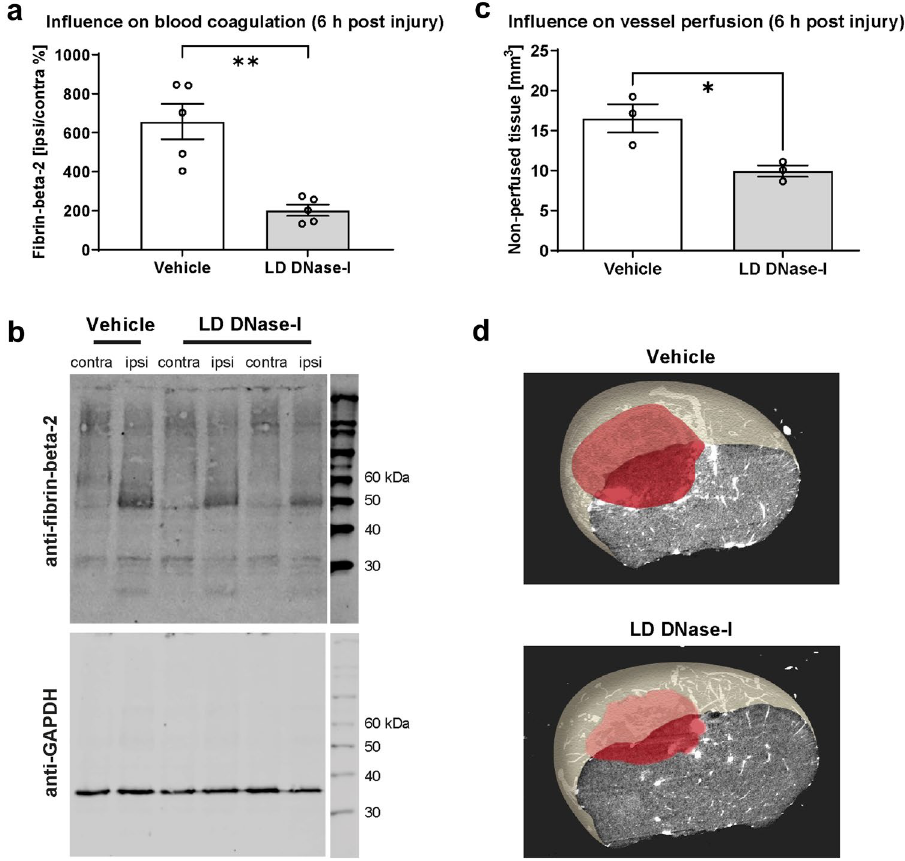
Figure 4. Regulation of coagulation and vessel perfusion post-CCI. ( a , b ) Western blotting of Fibrin-Beta-2 6 h post-CCI, blots were revealed by near infrared laser scanning, quantification was performed with ImageJ, indicating decreased expression following LD DNase-I treatment compared to vehicle (n = 5 mice/group). ( c , d ) Characterization of thrombus formation using cast material injection and micro-CT imaging (n = 3 mice/ group). The area of non-perfused brain tissue (red shading) did not differ significantly between treatment groups. A significance level p < 0.05 is marked with *, p < 0.01 with **, and p < 0.001 with ***. All data are presented as mean ± SEM; p values are adjusted for multiple comparisons by Sidak